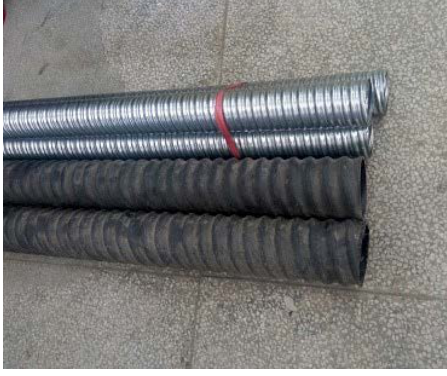
Figure 8. The used metal bellow and plastic bellow.